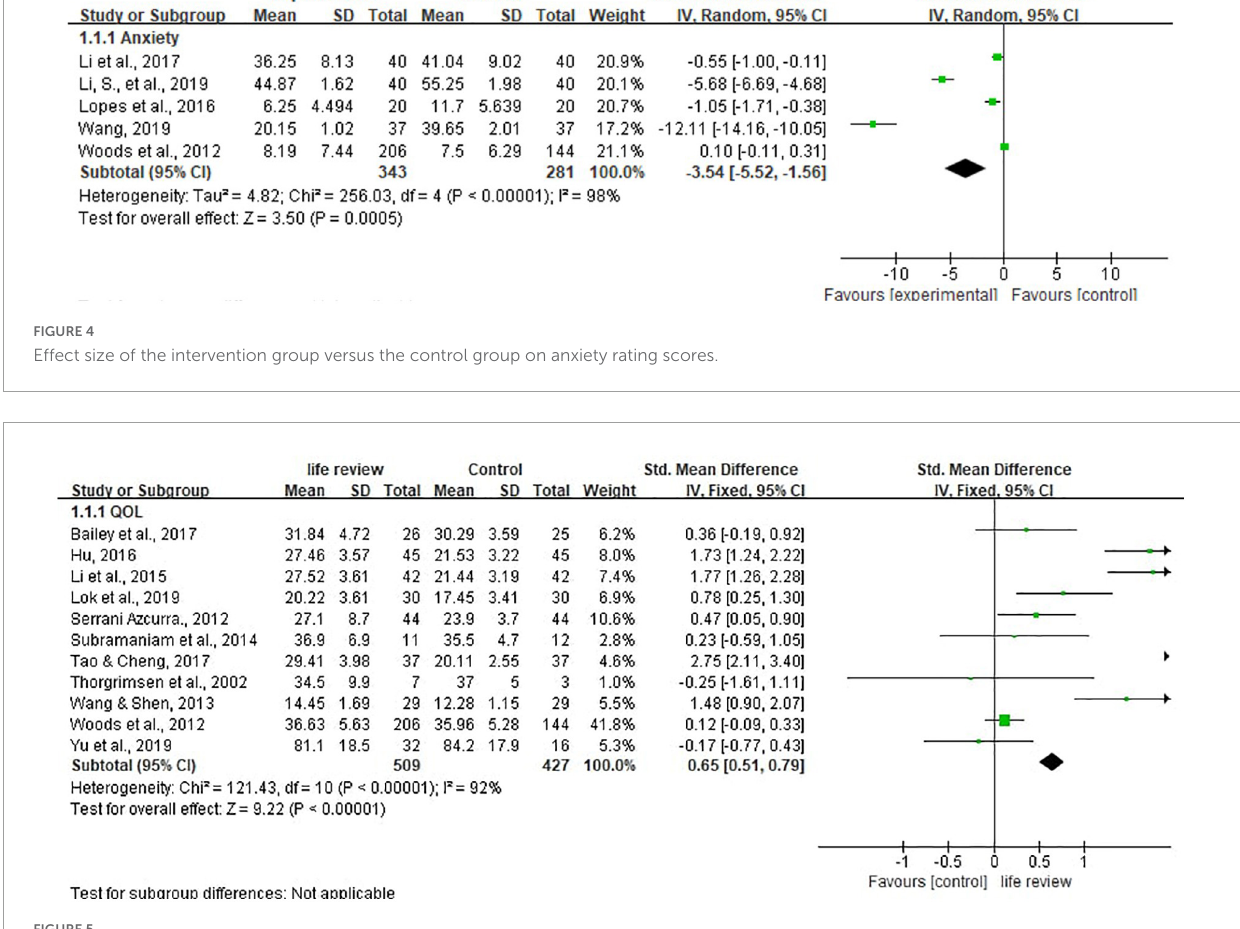
adults with LTI. A total of 34 studies representing 2,752 participants were identified. Our results indicated that life review could benefit older adults with LTI in decreasing anxiety, depression, and negative mood, and enhancing their positive mood and